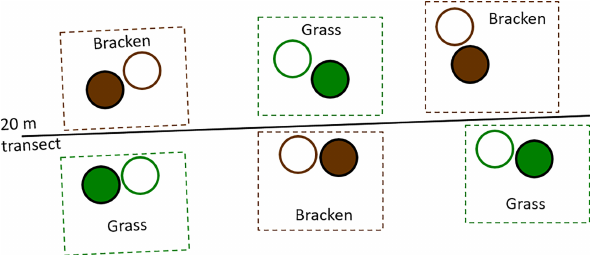
Figure 1. Schematic presentation of plots and CO 2 efflux measure- ment collars at both the forest and grassland study sites arranged along a 20m long transect. The dashed squares identify study plots (6) and circles represent soil collars for CO 2 efflux measurements ( n = 12); green and brown coloured shapes represent soil surface vegetated with grass and bracken respectively. Filled circles repre- sent vegetated area, while open circles represent collars with bare soil with vegetation temporarily removed for soil CO 2 efflux mea-